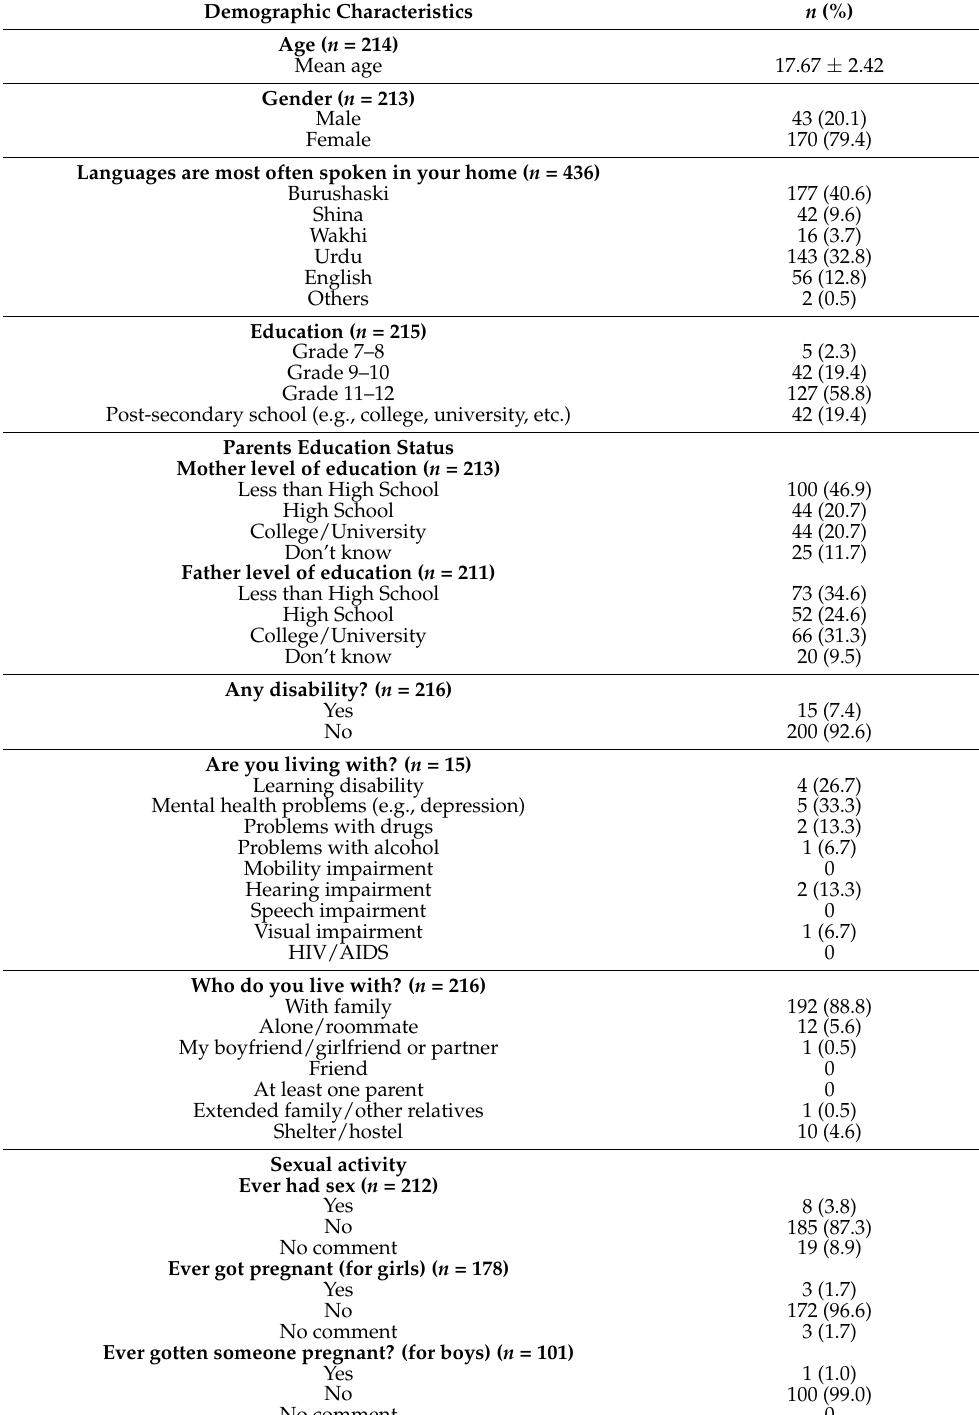
Table 1. Adolescents’ socio-demographics characteristics ( n =